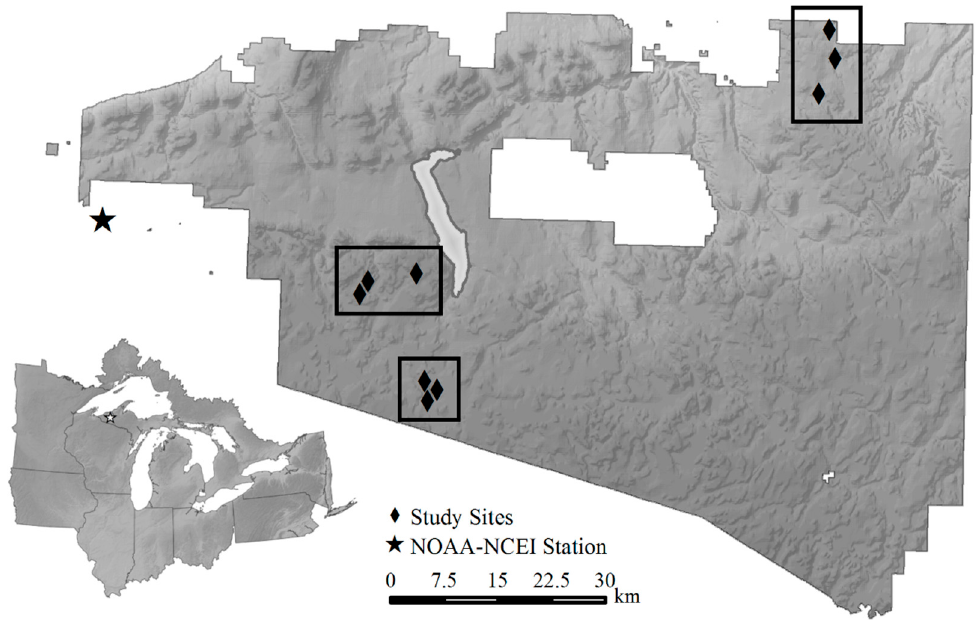
Figure 1. Map of Ottawa National Forest and black ash wetland study site locations within the Great Lakes region of North America (lower-left inset). Three geographically distinct locations (squares) were each subdivided into three treatment sites (diamonds). Regional precipitation data were obtained from the National Oceanic and Atmospheric Administration’s National Centers for Environmental Information (NOAA-NCEI) [44] station in Ironwood, Michigan (star).